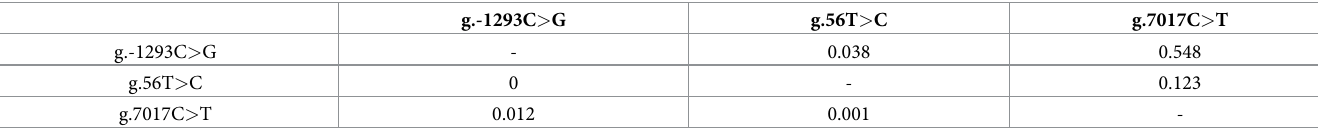
Table 6 summarizes the effects on milk production traits (rates of fat and protein and milk yield at 305-days) and SCSs. Polymorphism at g.56T > C was strongly correlated with SCS ( P < 0 . 05 ). Cattle that showed the homozygous genotype CC, rather than TC or TT, at position 56 also showed significantly lower SCS ( P < 0 . 05 ). Polymorphism at g.-1293C > G was related to protein rate for studied Chinese Holstein cattle ( P < 0 . 05 ). The homozygous genotype GG at position -1293 had significantly higher protein content than those with genotypes of CC and CG ( P < 0 . 05 ). However, no significant correlation between g.-1293C > G/g.7017C > T polymor- phism and SCS/milk traits was found in 821 Chinese Holstein cattle ( P > 0 . 05 ) (Table 6). The polymorphism at g.56T > C and g.7017C > T was significantly correlated with serum ACH50 values in 354 Chinese Holstein cows ( P < 0 . 01 ) (Table 7). The homozygous genotype CC at position 56 had significantly higher ACH50 than the genotypes of TC and TT ( P < 0 . 01 ), while the homozygous genotype CC at position 7017 had significantly lower ACH50 than Table 5. Analysis of pairwise linkage disequilibrium in C3